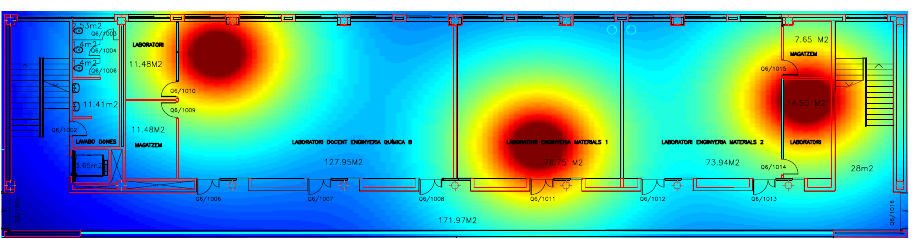
Figure 6. Simulated distribution of RSS in an indoor